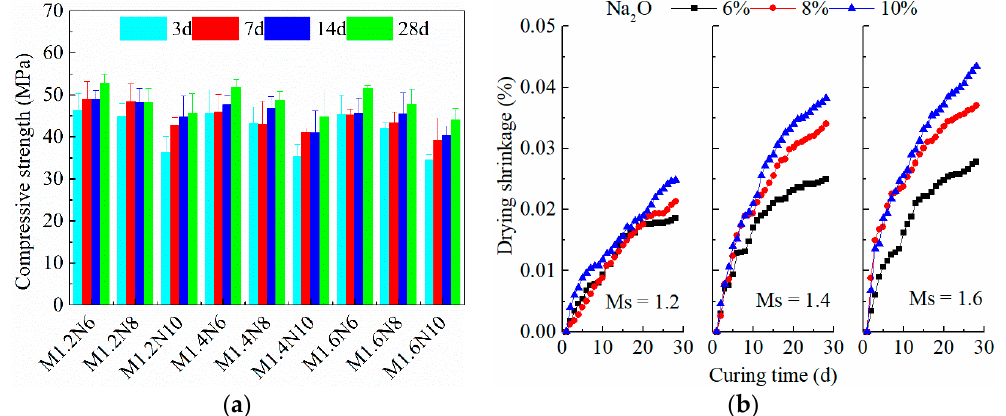
Figure 8. Effects of silicate modulus and Na 2 O content on ( a ) compressive strength of AASC specimens; ( b ) drying shrinkage of AASC specimens.